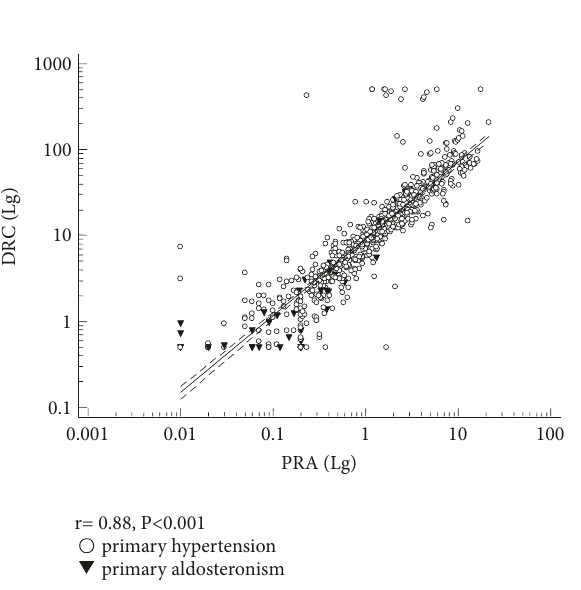
Figure 2: Regression curve of PRA and DRC. Dashed lines: confidence interval; continuous line: regression curve. R 2 =0.7662, Y=0.9573+0.8925 × X. PRA: plasma renin activity; DRC: direct renin concentration.